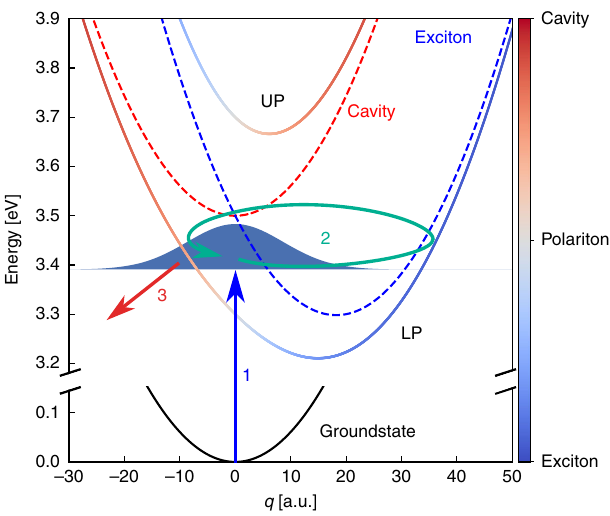
Fig. 1 Polaritonic potential energy surface (PoPES). PoPES in the single- excitation subspace for a single molecule coupled to a con fi ned light mode. The red dashed line represents the uncoupled potential energy surfaces (PES) for a ground-state molecule with a single photon in the cavity, whereas the blue dashed line represents the molecular excited-state PES with no photons present and the black solid line represents the ground- state PES of the molecule. The solid blue/gray/red curves are the lower and upper polariton PES, with the color encoding the excitonic/polaritonic/ photonic character as a function of nuclear position q . The fi lled blue curve represents the vibrational ground-state wavefunction of the electronic ground-state PES. The arrows represent the excitation by the laser pulse (1), oscillatory motion of the excited vibrational wavepacket (2) and radiative emission